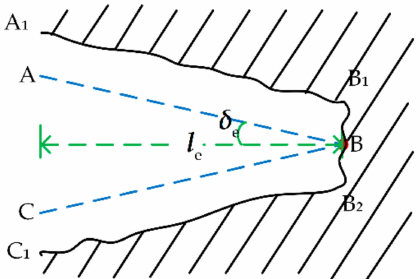
Figure 6. Shape features of the uncertain